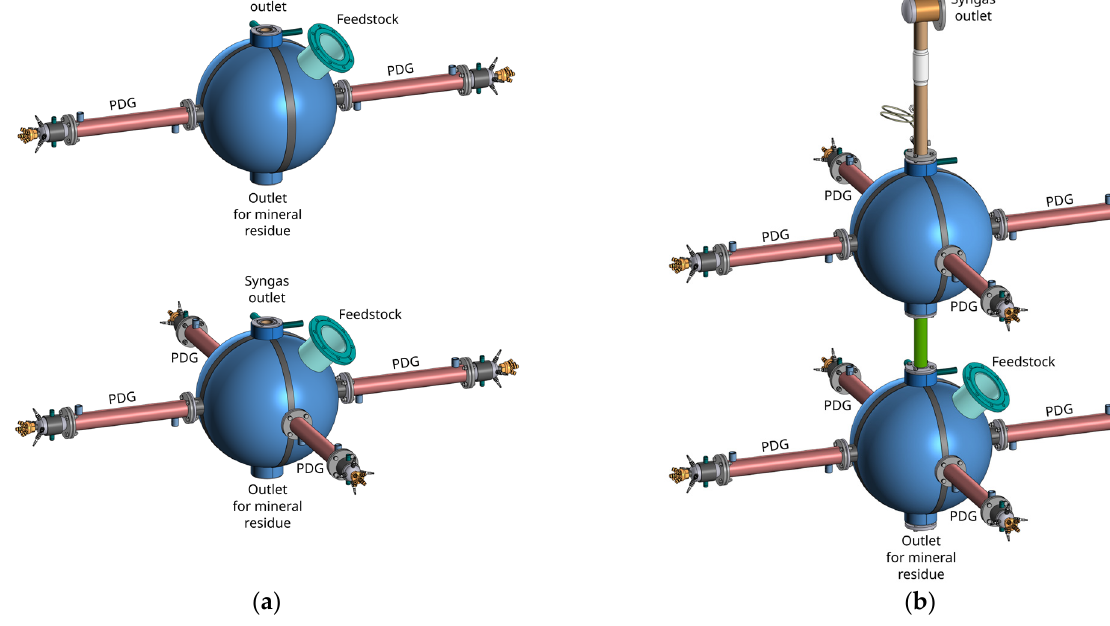
Figure 2. Schematics of the units for organic waste gasification by the USS: ( a ) a single flow-through gasifier with one and two pairs of PDGs; ( b ) a cascade of two flow-through gasifiers with two pairs of PDSs.